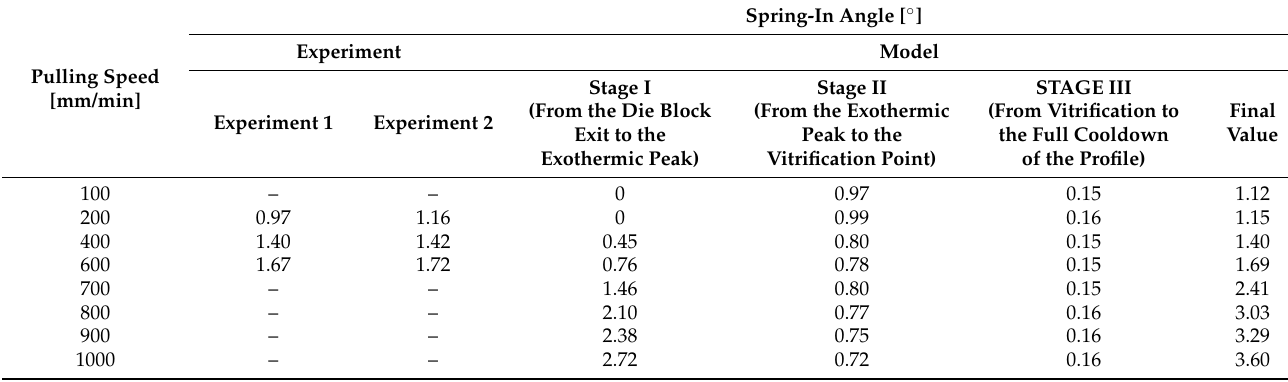
Figure 7. Simulation results: distribution of temperatures ( a – d ) and degree of polymerization ( e – h ) in the cross-section of the L-shaped profile: ( a ) pulling speed—200 mm/min, immediately after the die exit; ( b ) pulling speed—600 mm/min, immediately after the die exit; ( c ) 1000 mm/min, immediately after the die exit; ( d ) 1000 mm/min, at 200 mm after the die exit, or immediately after the post-die cooling tool; ( e ) 200 mm/min, immediately after the die exit; ( f ) 600 mm/min, immediately after the die exit; ( g ) 1000 mm/min, immediately after the die exit; ( h ) 1000 mm/min, at 200 mm after the die exit or immediately after the post-die cooling tool. Exothermic peak and vitrification were analyzed in Zone E shown to the right in ( h ). Table 1. Spring-in of L-shaped profiles pultruded at different pulling speeds (experimental results and predictions). Contributions of stages to the final spring-in